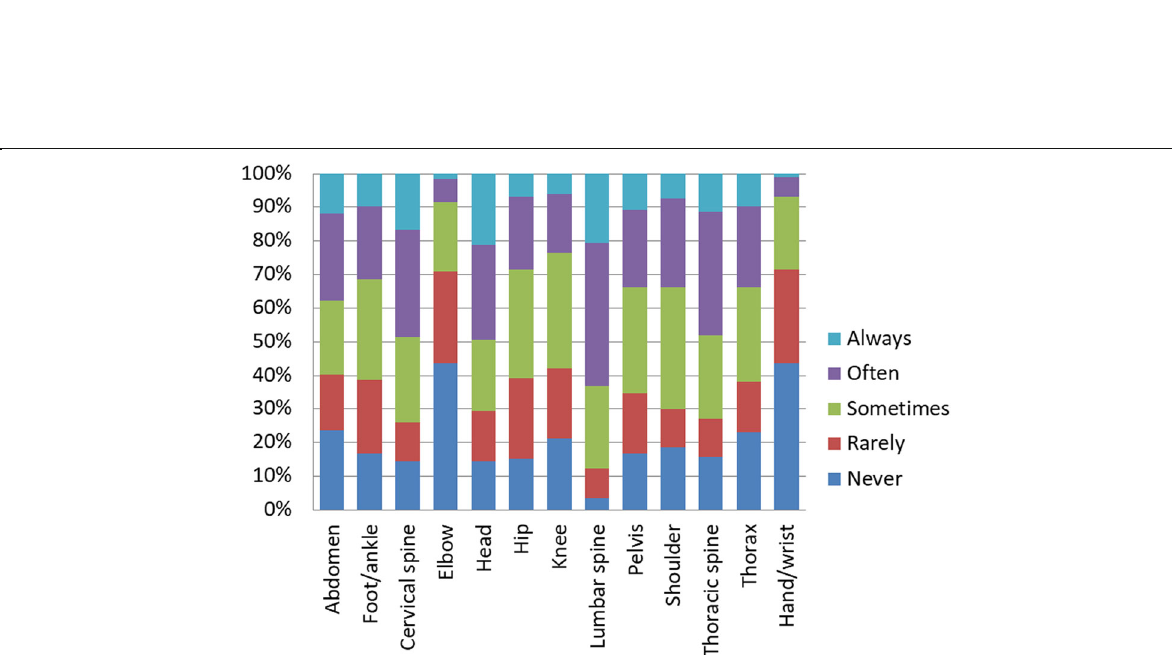
Fig. 2 «How often did you engage self-directed practice on practice buddies with the following conditions?» . Students had to choose one answer (Always, Often, Sometimes, Rarely, Never) for each of the 25 clinical conditions listed. The most common clinical condition encountered was ‘ Low back pain ’ . The less common clinical condition encountered was ‘ Infants colics ’ . TMJ: Temporo-Mandibular Joint; GERD: Gastroesophageal reflux disease; IBS: Irritable Bowel Syndrome